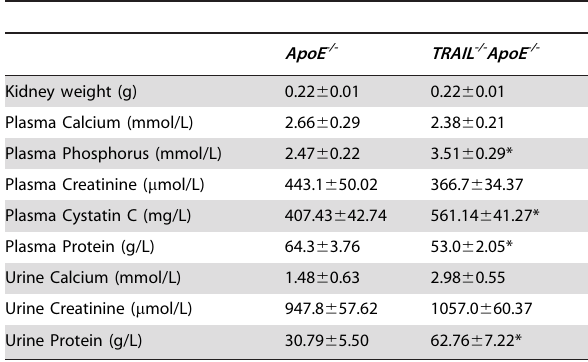
Table 2. Organ weights, blood and urine measurements from ApoE -/- and TRAIL -/- ApoE -/- mice after 20 w HFD.